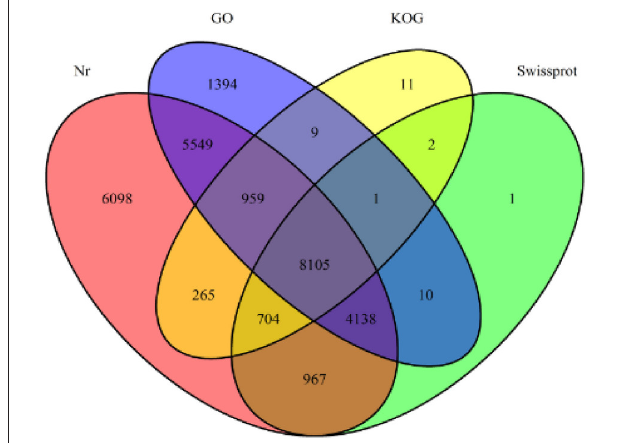
FIGURE 3 | The number of unigenes annotated by BLASTX with an E -value threshold of 10 −− 3 against protein databases. The numbers in the circles indicate the number of unigenes annotated by single or multiple databases.